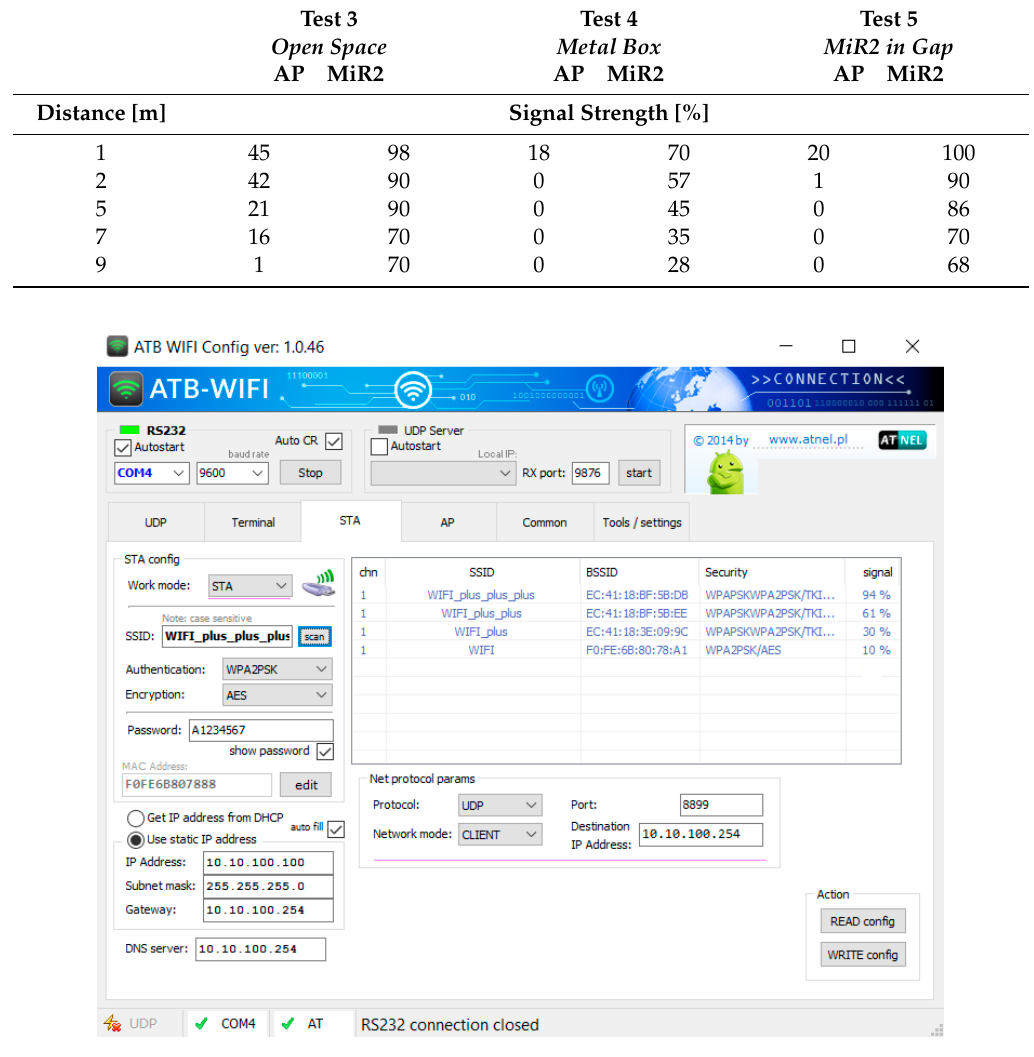
Figure 11. Screenshot of the ATNEL-WIFI232-T module configuration program shows WiFi network with three MiR2 routers. The source for measurement data included in Tables 2 and 3. Table 2. The results of the AP strength signals during the tests 1 and 2.